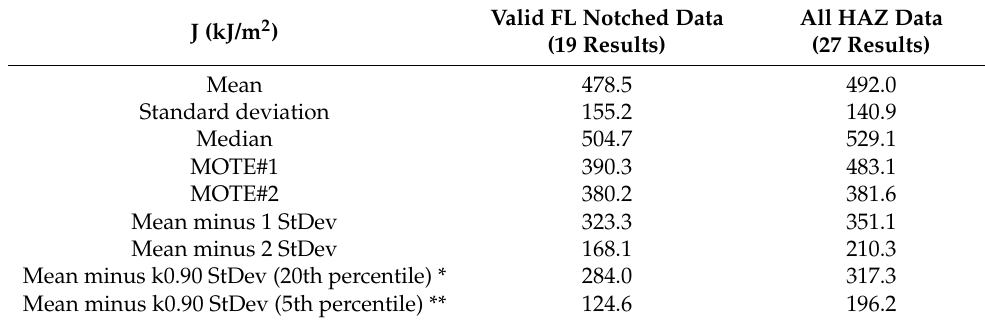
Table 5. Statistical definitions of fracture toughness, J, based on both the full set of HAZ notched specimens, and on the sub-set of valid specimens with notch tips within 0.5 mm of the fusion line.